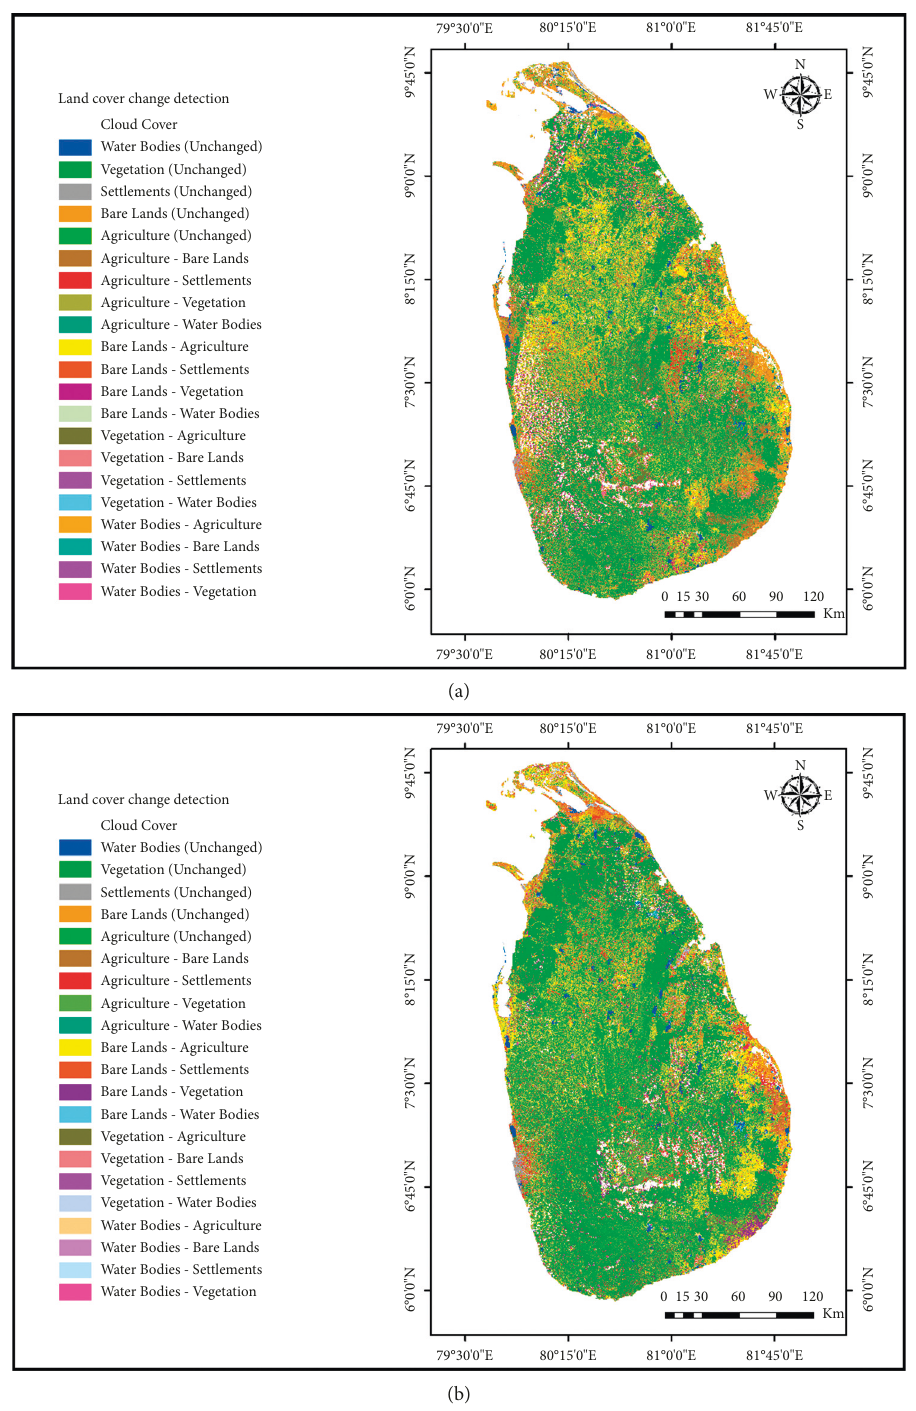
Figure 6: Land use and land cover change. (a) From 2000 to 2010. (b) From 2010 to